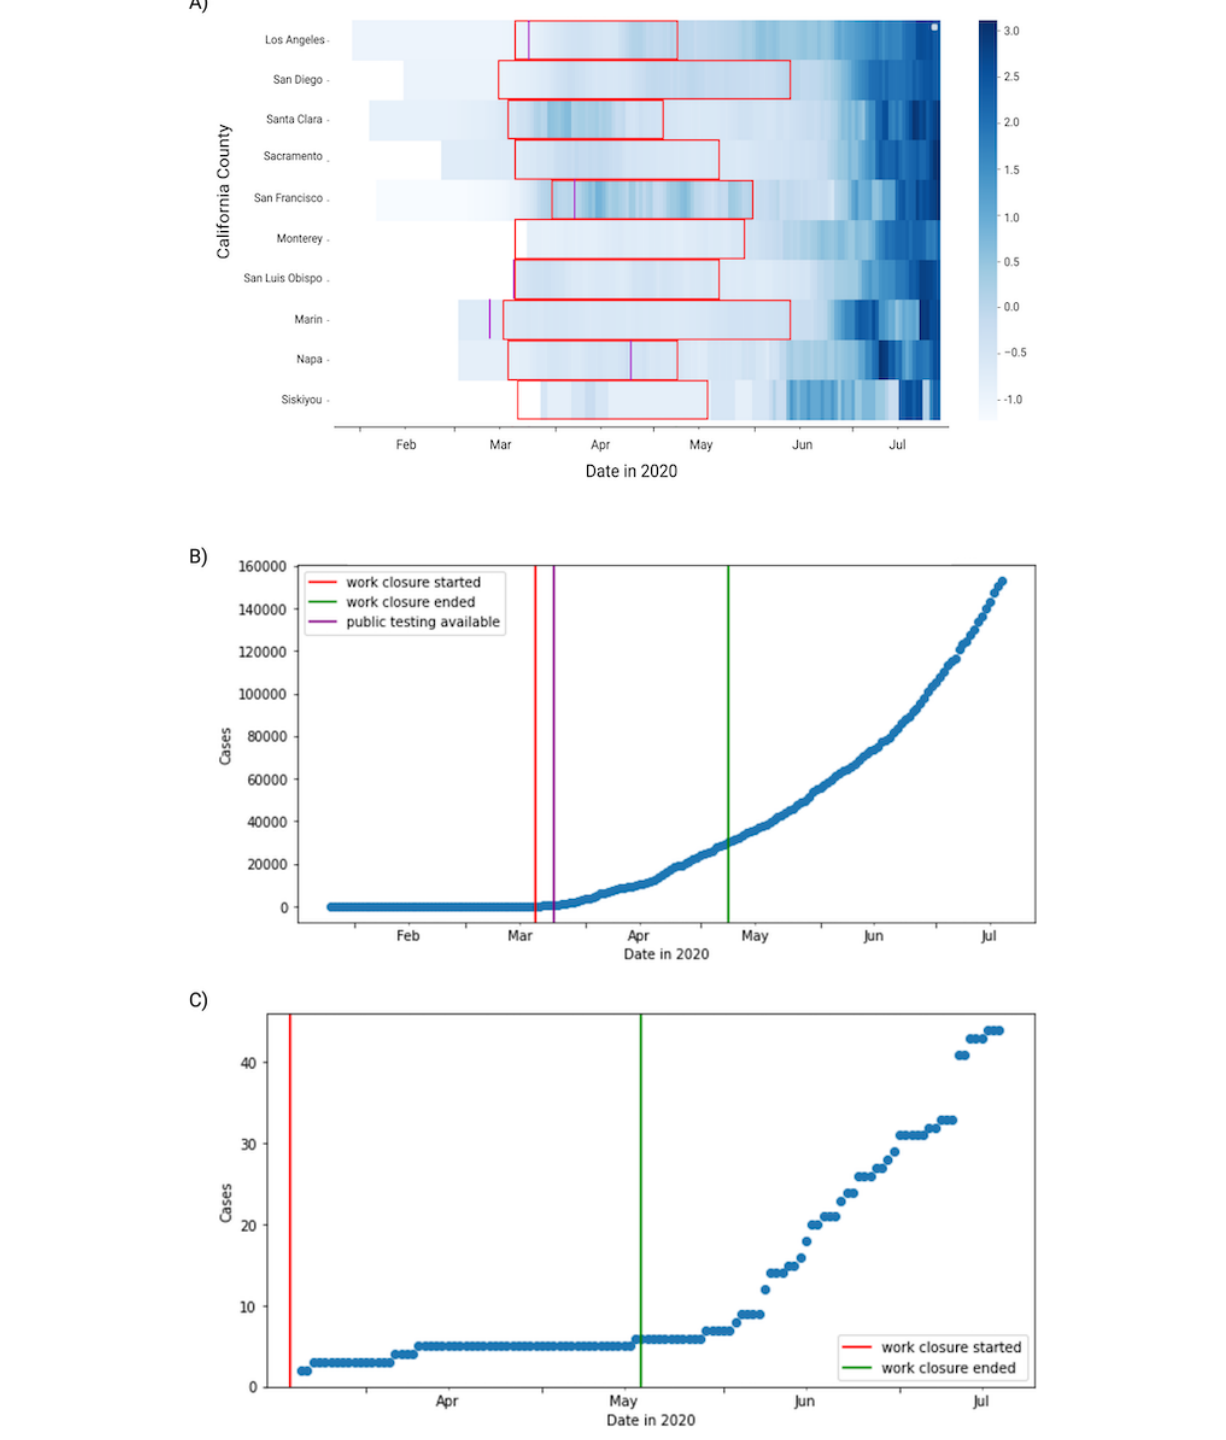
Figure 2. Variability in California county policies in time and in relation to caseloads. (A) Time-series heatmap of the 7-day simple moving average of daily cases plotted for 10 representative California counties in order of descending population, all normalized by county. The red rectangle demarcates the period for which the county had nonessential workplaces closed. The purple line indicates if and when public testing became available. (B) Plot of the total number of county cases as a timeline with county-level nonessential work closure policy and public testing times labeled for Los Angeles County. (C) Plot of the total number of county cases as a timeline with county-level nonessential work closure policy times labeled for Siskiyou